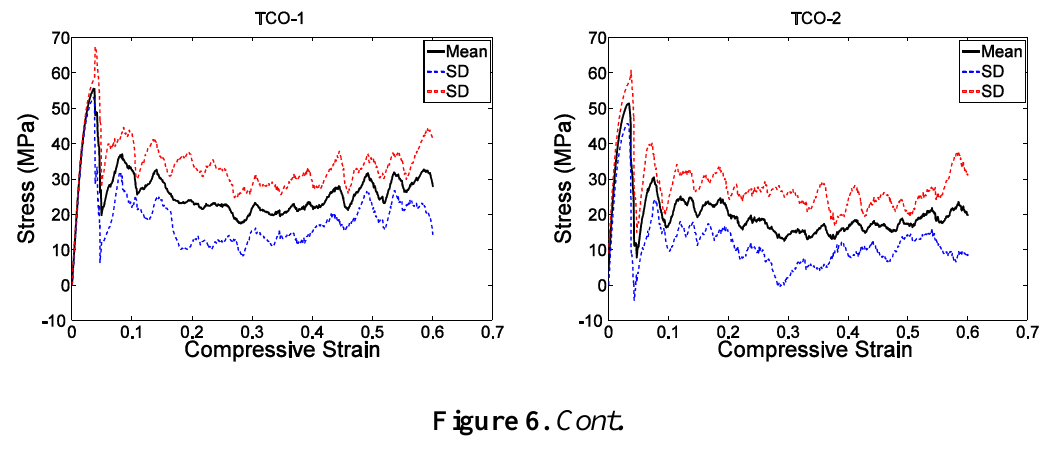
Figure 5. Compressive stress- versus -compressive strain curves for specimens based on the truncated cube unit cell and with different porosities (see Table